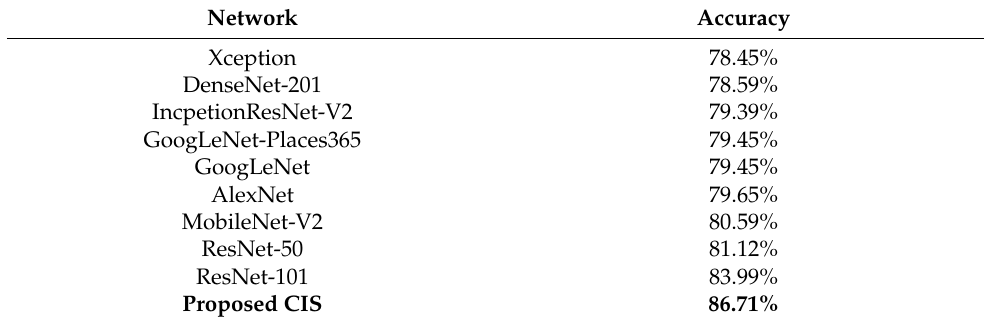
Table 5. The proposed system with the collective decision and individual network performances in order of increasing performance—test phase.